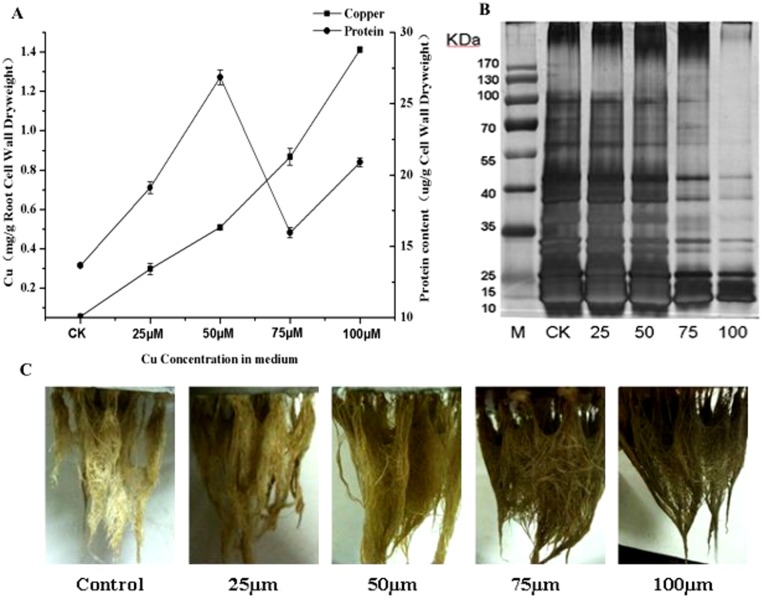
Effect of different copper concentration on the cell wall protein and copper ions in Elsholtzia splendens's root cell.A: The content of copper and protein every root cell wall dry weight. B: SDS-PAGE of root cell wall protein under different copper stress. C: Root growth patterns of control and copper-stressed plants during different copper concentration. Data presented are mean ±SE (n = 20),*Significant mean differences from control at p = 0.05 in multiple comparison by LSD test.